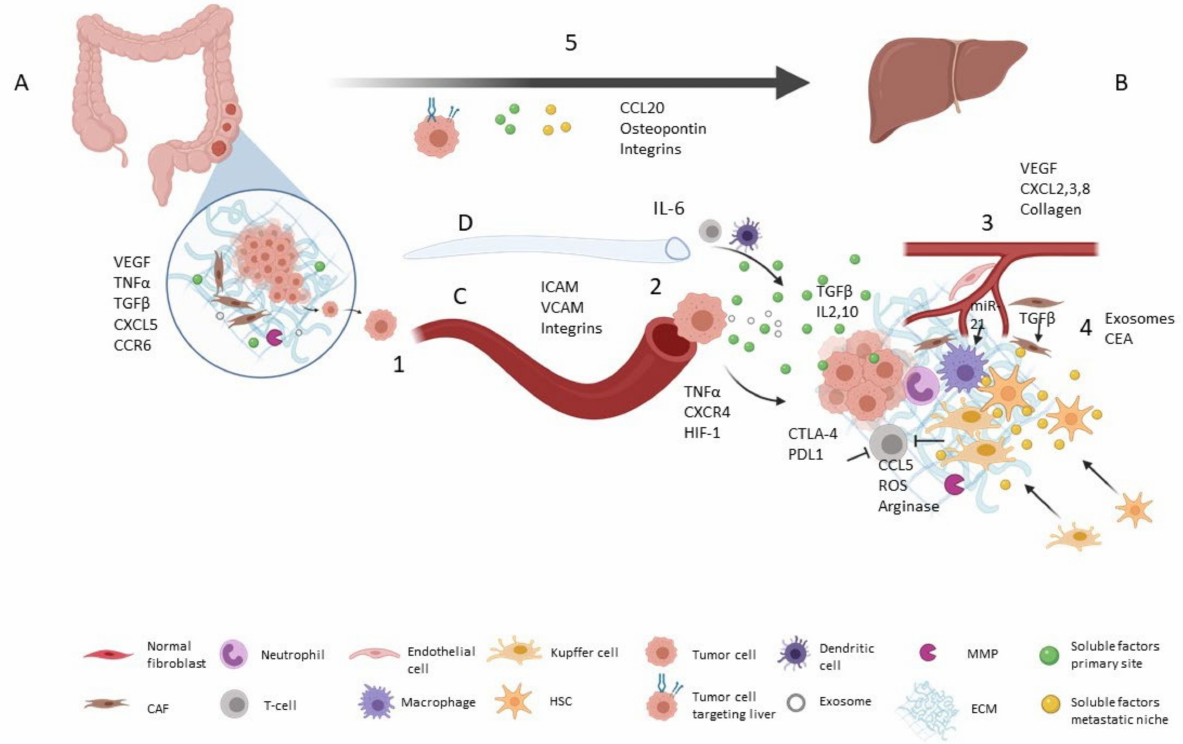
Figure 1. Pre-metastatic niche promotion by tumor microenvironment. Primary tumor ( A ) secretes soluble factors to prepare pre-metastatic niche ( B ). (1) Tumor cell leaves primary site, moving across extracellular matrix (ECM) and reaching blood stream ( C ) or lymphatic vessel ( D ) [2,8,13]. (2) Extravasation is mediated by vascular endothelial cell receptors and tumor cell adhesion molecules (Intercellular Cell-Adhesion Molecule (ICAM), Vascular Cell-Adhesion Molecule (VCAM)) [6]. Moreover, levels of TNF α , C-X-C chemokine Receptor type 4 (CXCR4) and Hypoxia-inducible Factor 1 (HIF-1) act in extravasation [3,6,8]. (3) Presence of VEGF, CXCL2-3-8 promotes niche vascularization [11,14]. Collagen provides scaffold for new vessels [5]. (4) In premetastatic niche, tumor-derived secreted factors recruit Kupffer cells, hepatic stellated